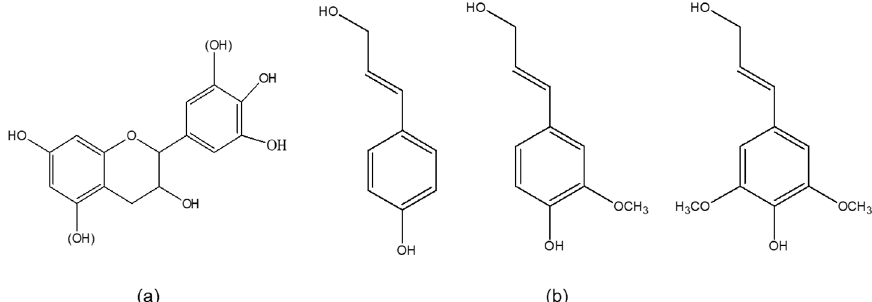
Figure 1. Structure of flavonoid unit of condensed tannins ( a ) and phenylpropanoid units of lignin ( b ).